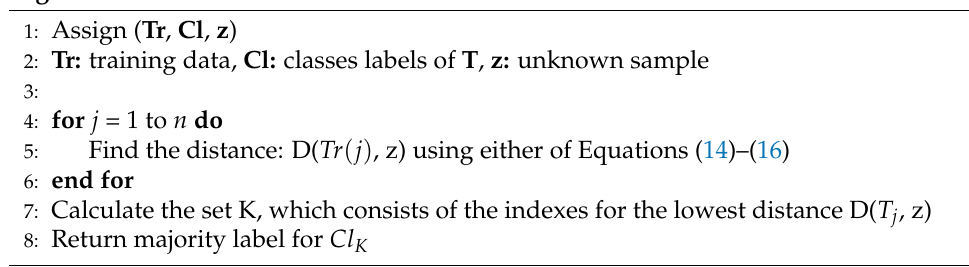
Algorithm 1 KNN Pseudocode